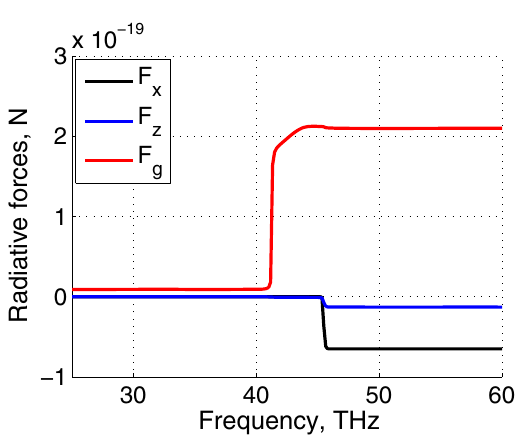
Figure 5. Real and imaginary parts of the polarizability α [F · m 2 ] of the nanoparticle, made of doped silicon with concentration of carriers 9 × 10 19 cm − 3 .